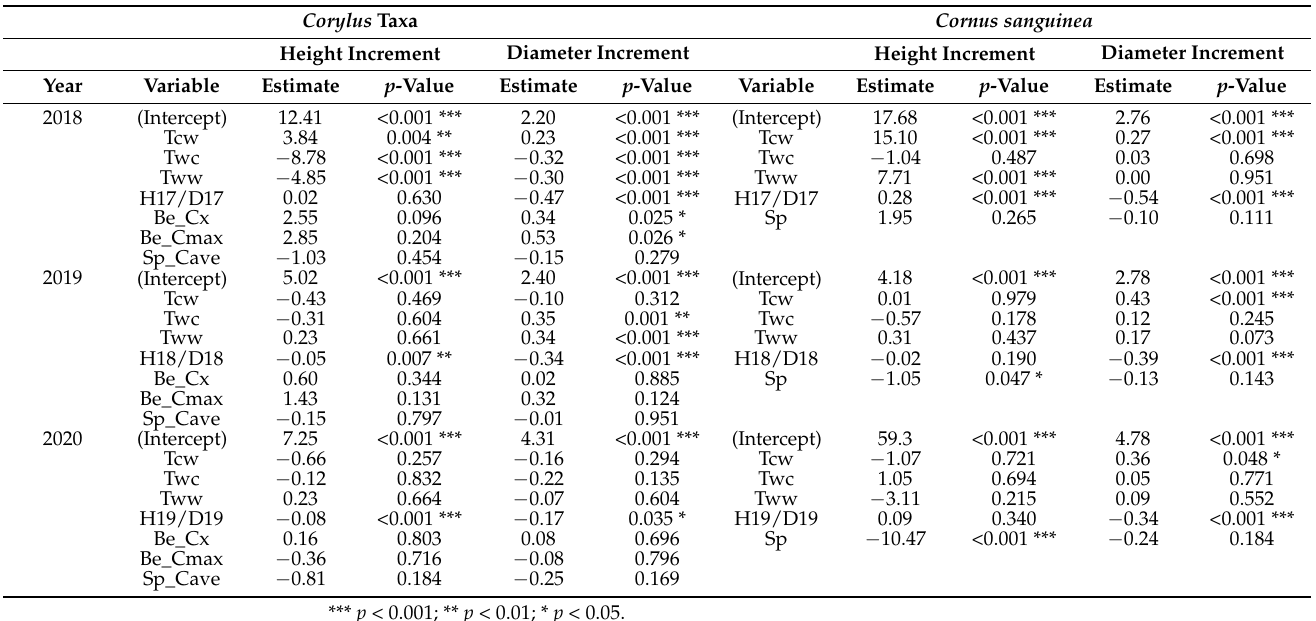
Table 3. Estimates and p -values for the modeled height and diameter increments for the years 2018 until 2020 for the Corylus taxa and for Cornus sanguinea . For the Corylus taxa, the standard taxon/region is the Belgian Corylus avellana to which the Belgian intermediate forms (Be_Cx), the Belgian Corylus maxima (Be_Cmax), and the Spanish Corylus avellana (Sp_Cave) are compared. For Cornus sanguinea , the Belgian provenance is the standard provenance to which the Spanish provenance (Sp) is compared. The “cold–cold” condition in the temperature treatments during 2018 is the standard to which the other three conditions “cold–warm”, “warm–cold”, and “warm–warm” are compared (Tcw, Twc, and Tww, respectively). H17/D17 to H19/D19 indicates that, in the models for the height increments, the starting height is present (H17 until H19), whereas, for the models of the diameter increments, the starting diameter is present (D17 until D19).